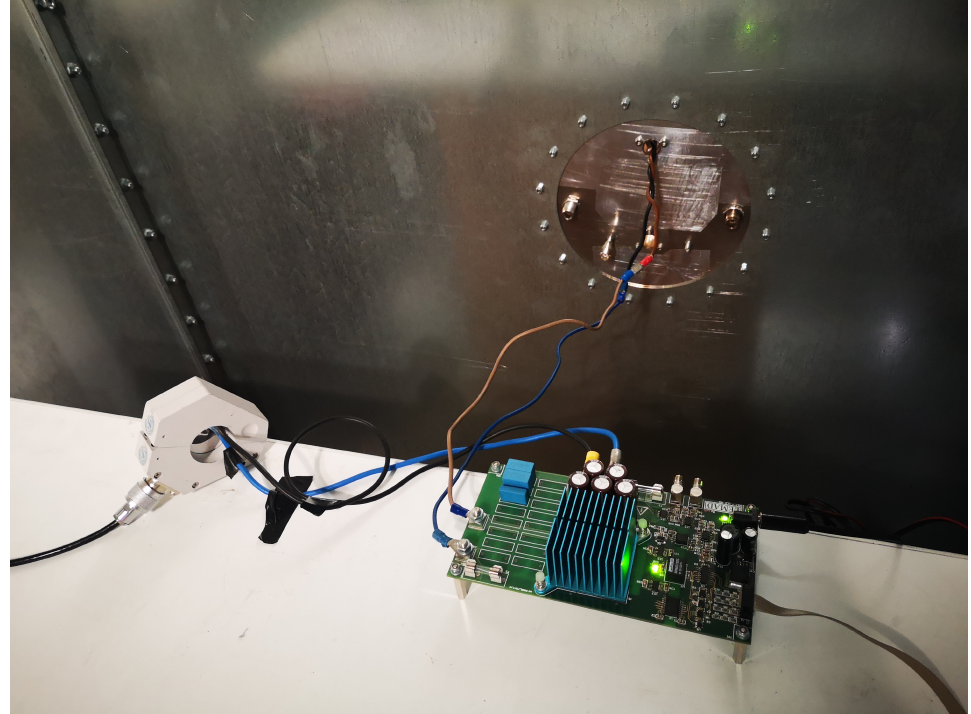
Figure 2. WPT converter setup for measurement of input impedance and current emissions. Shown measurement is common mode; the looped black wire is for the differential-mode measurement, as in Figure 1; DC power supply and LISN not visible, located beneath the